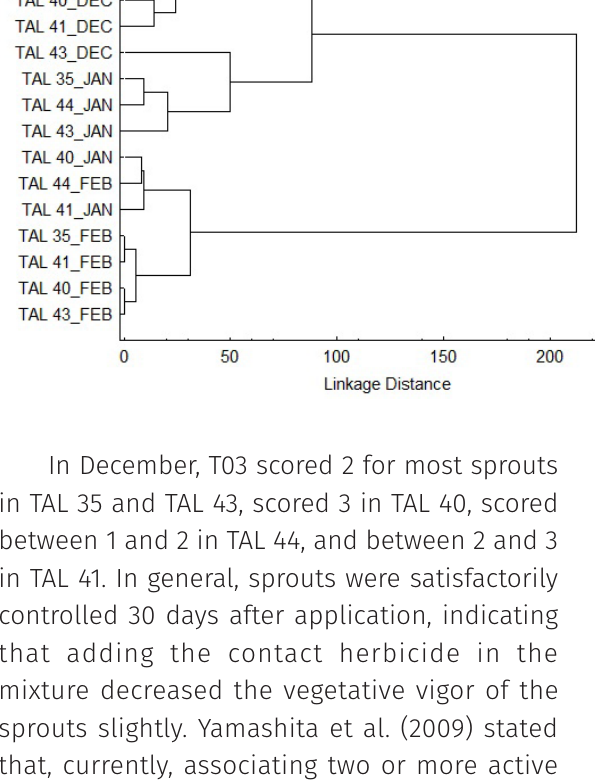
Figure 5. Dendrogram of the clustering analysis results of the different fields and evaluation periods for the scores in